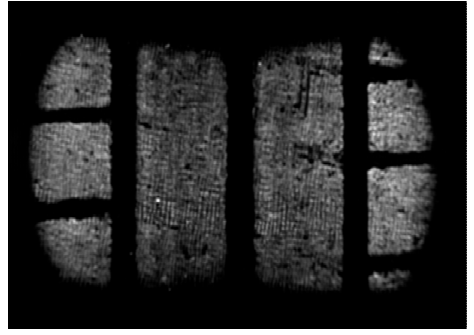
Figure 18. Area without defects.